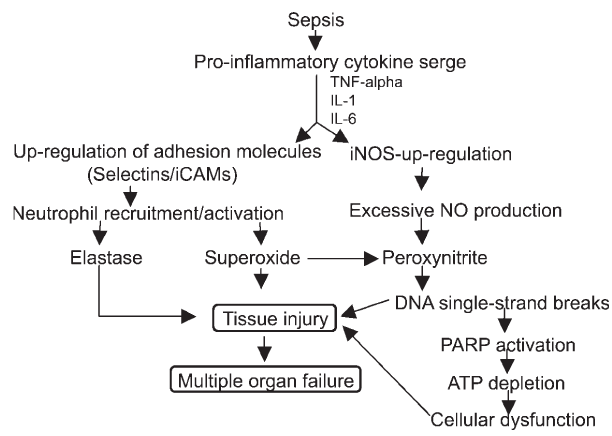
Figure 1 - Role of selections and excessive nitric oxide in sepsis-related tissue